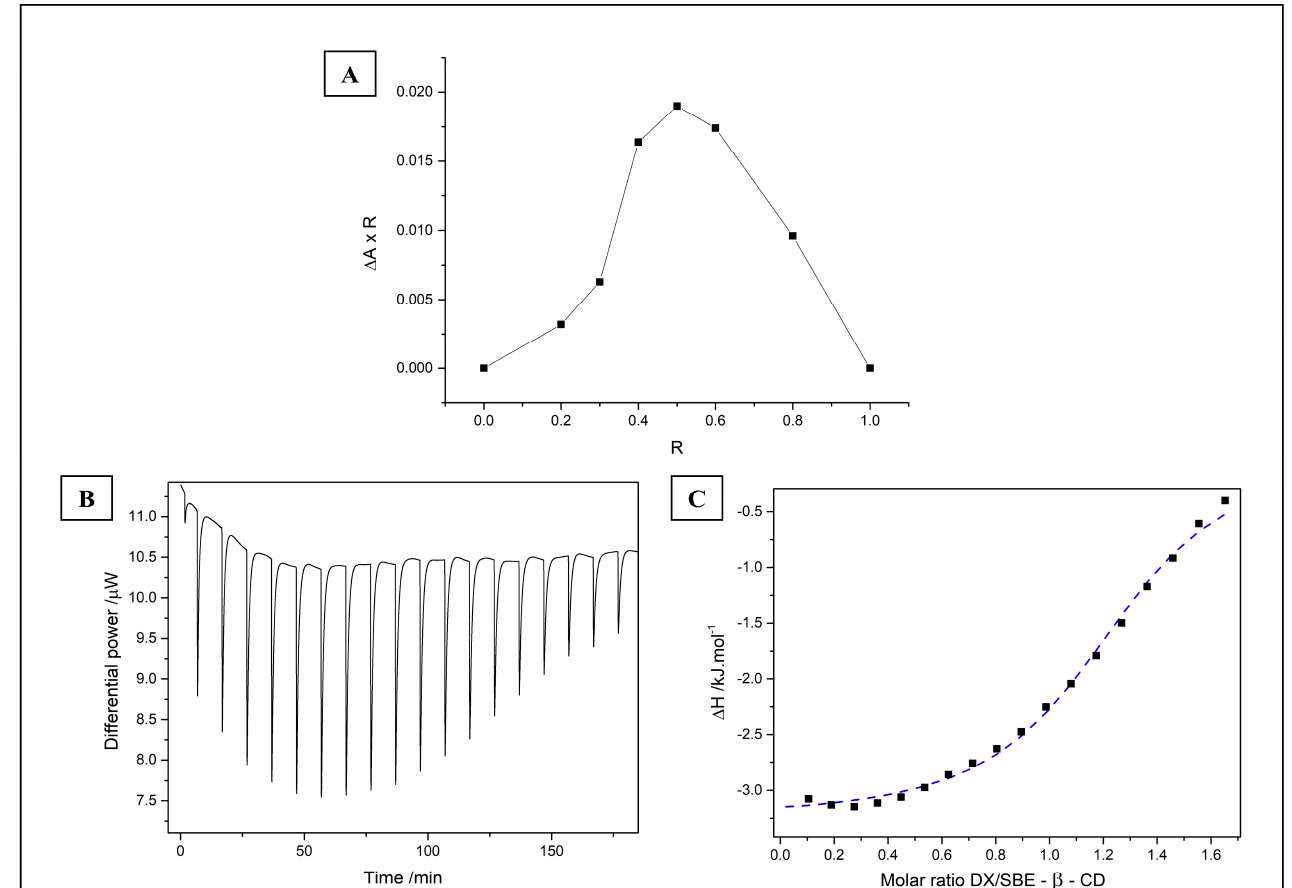
Figure 1. ( A ) Job’s plot of UV/Vis absorbance at different ratios (R) of doxycycline DX and SBE- β -CD in acetate buffer (pH 5.0). Delta A = delta absorbance between free DX and DX in complex form. ( B ) Raw calorimetric data of the titration of DX with SBE- β -CD. ( C ) Enthalpogram of the binding at pH 5.0/25 °C in 10 wt% solution of ethanol in water. Dashed blue line = fitting into the “one set of sites” model.